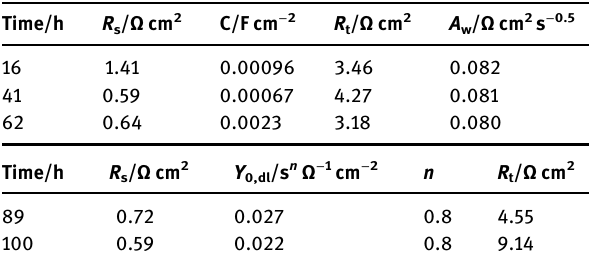
Table 5: EIS fi tting results of Inconel 625 alloy in ternary chloride